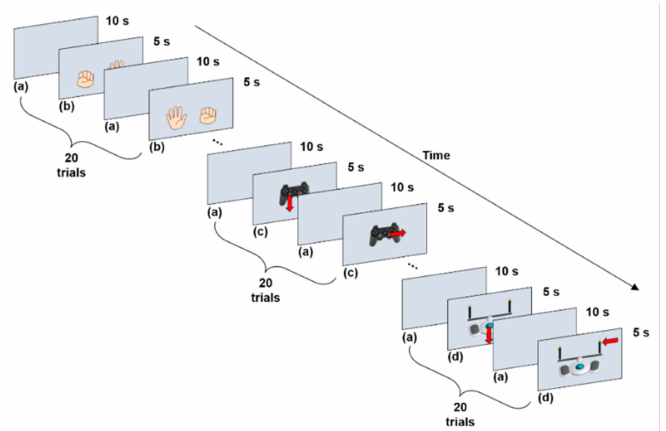
Figure 3. Sequence of the experimental task: ( a ) inter-stimulus interval; ( b ) grip task; ( c ) gamepad task; and ( d ) balance handle